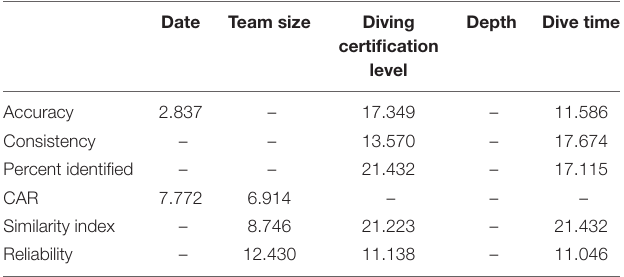
TABLE 3 | Percentage of increase of reliability parameters depending on independent variables.